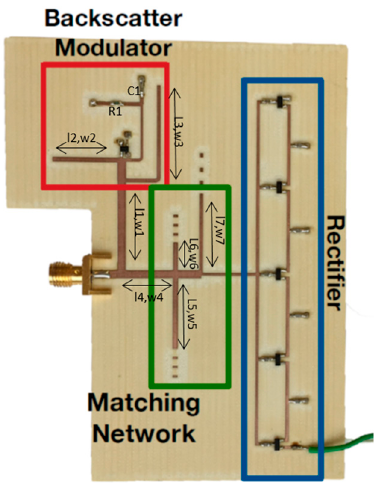
Figure 3. Photograph of implemented system with backscatter modulator combined with Wireless Power Transmission (WPT). Element values are L1 = 21.2 mm, W1 = 1.87 mm, L2 = 15.1 mm, W2 = 1.0 mm, L3 = 21.9 mm, W3 = 0.8 mm, L4 = 11.3 mm, W4 = 1.87 mm, L5 = 17.1 mm, W5 = 1.2 mm, L6 = 6.7 mm, W6 = 1.1 mm, L7 = 18.6 mm, W7 = 0.7 mm, R1 = 50 Ω , and C1 = 47 pF. Substrate for the transmission lines is Astra MT77, thickness = 0.762 mm, ε r = 3.0, tan δ = 0.0017.